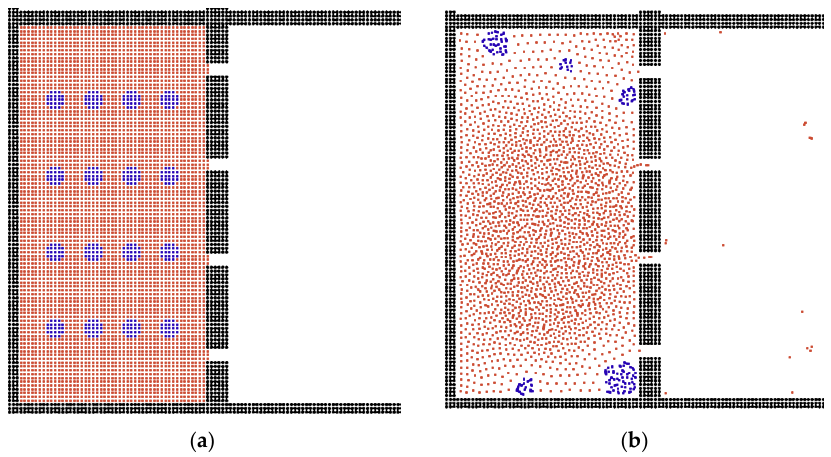
Figure 10. (a) The initial condition of water in oil. (b) The separation result for water in oil system. The red particles represent the oil phase and the blue particles represent the water phase.